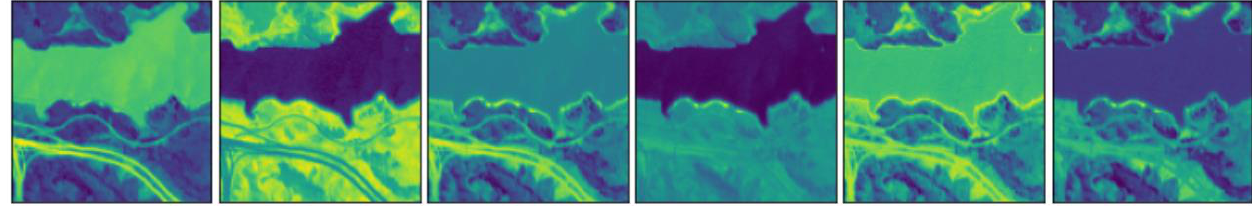
Figure 11. The maps of the gamma 𝜸 inferenced by GBM_AE on Jasper Ridge. From left to right for different second-order interaction terms: road-water, road-tree, road-soil, water-tree, water-soil and tree-soil.